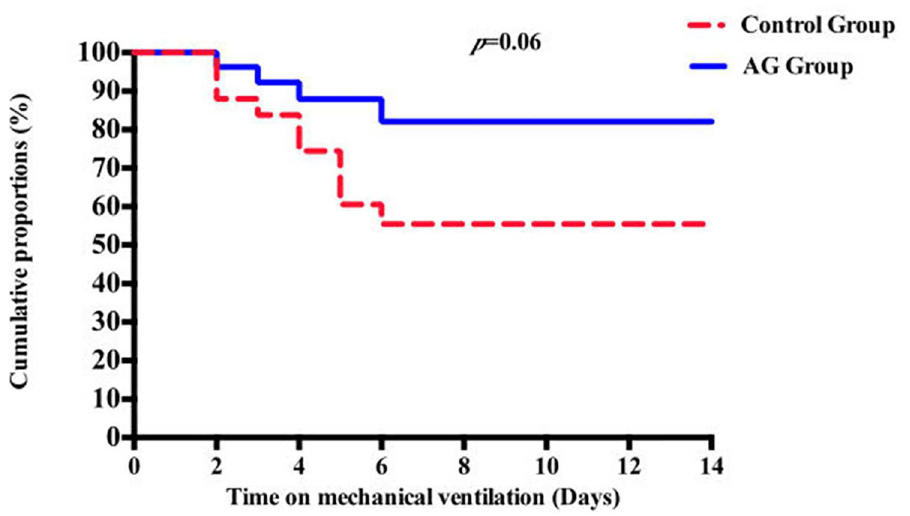
Fig 4. Cumulative rates of patients remaining free of VAP in the AG group and control group, using the Kaplan-Meier method. VAP , Ventilator-Associated Pneumonia; AG , Anapnoguard.